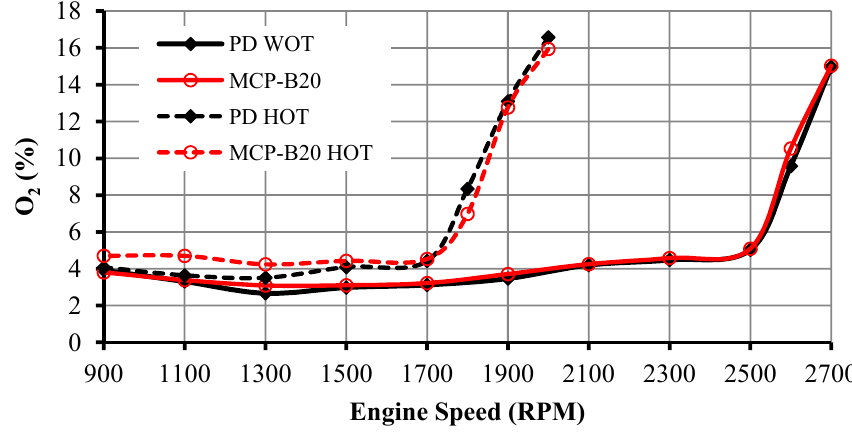
Figure 12. The relationship between tractor engine speeds (RPM) and O and MCP-B20.